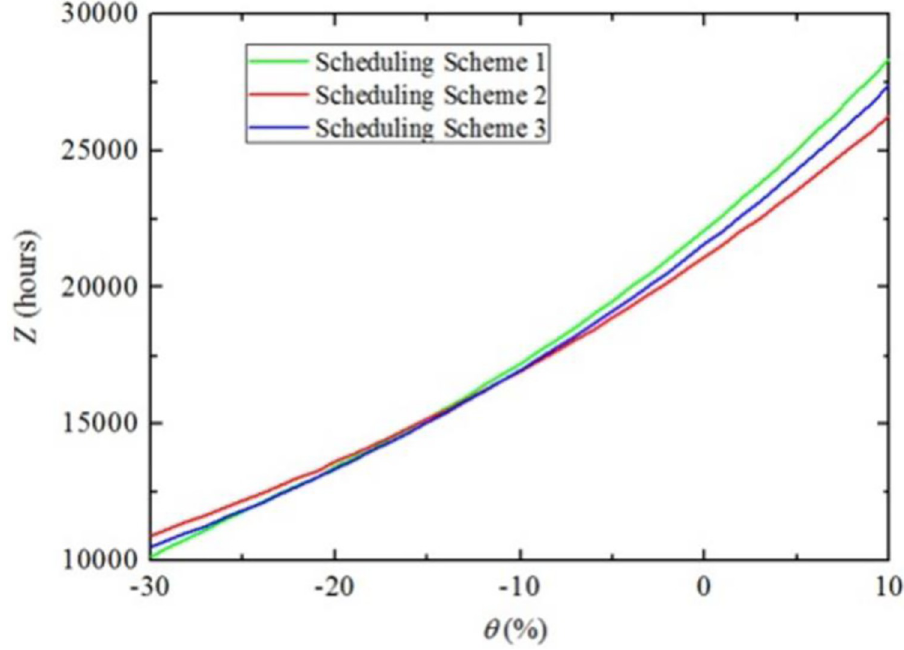
Fig 6. Z of the three maintenance scheduling schemes for the increase of q w by θ